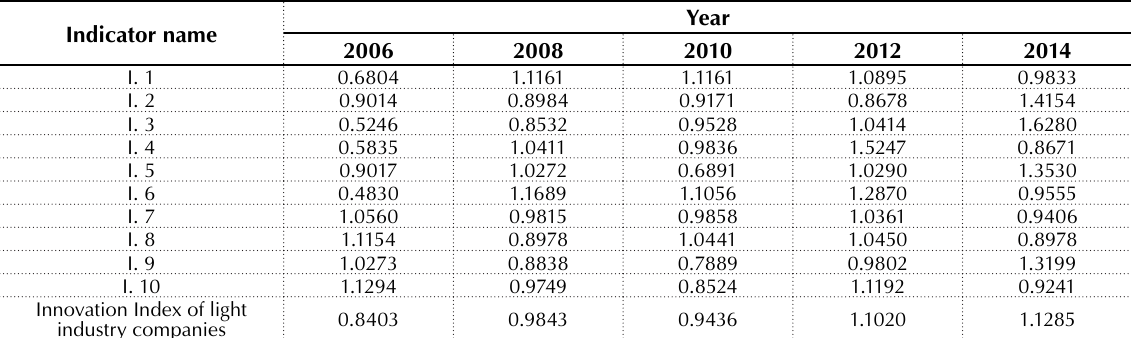
Source: The calculations are based on the data of Table 2.